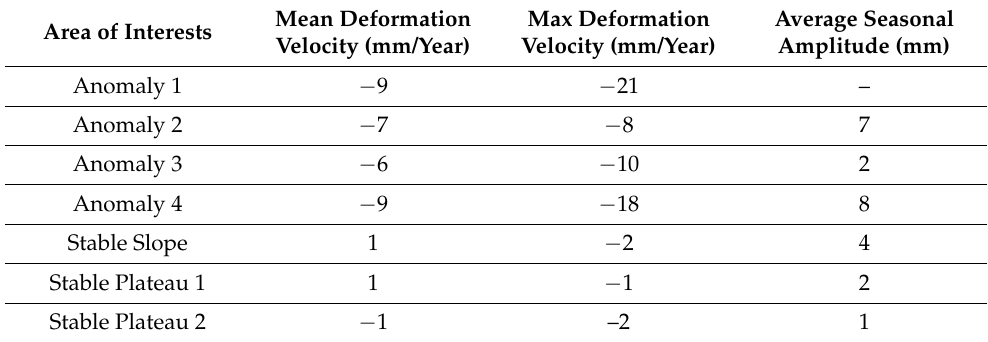
Table 4. ISBAS LOS Velocity